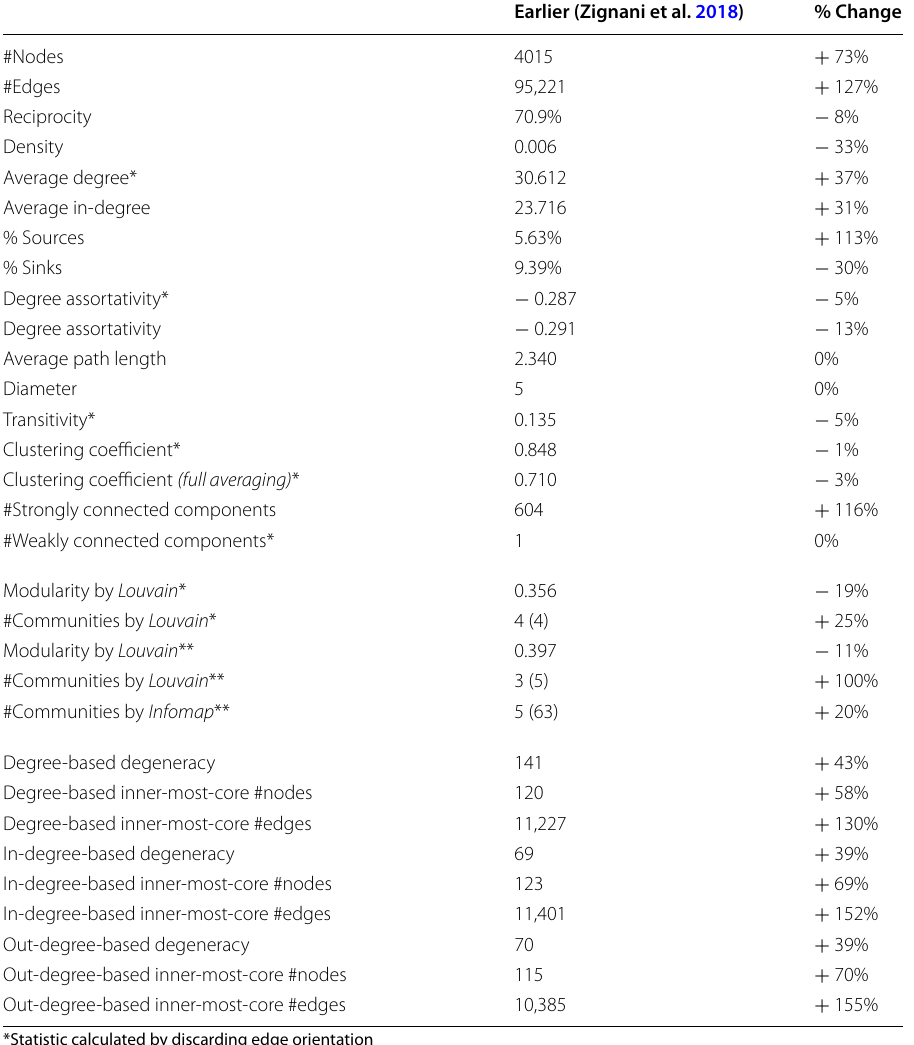
Table 7 Evolution of the I nstancEs network through a comparison of structural characteristics with the earlier state-of-the-art network. Percentage changes refer to the increase/decrease of a statistic from the value observed in the earlier network. For the community statistics, percentage values refer to the number of communities containing at least ten